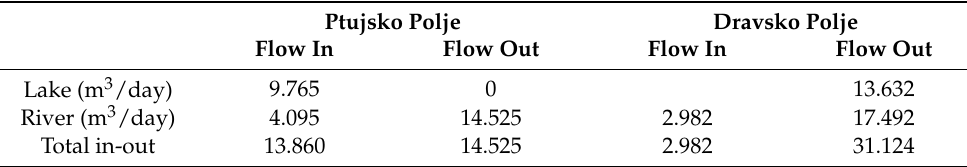
Table 7. Flow budget result for the intersecting part Ptujsko–Dravsko polje aquifer. Ptujsko